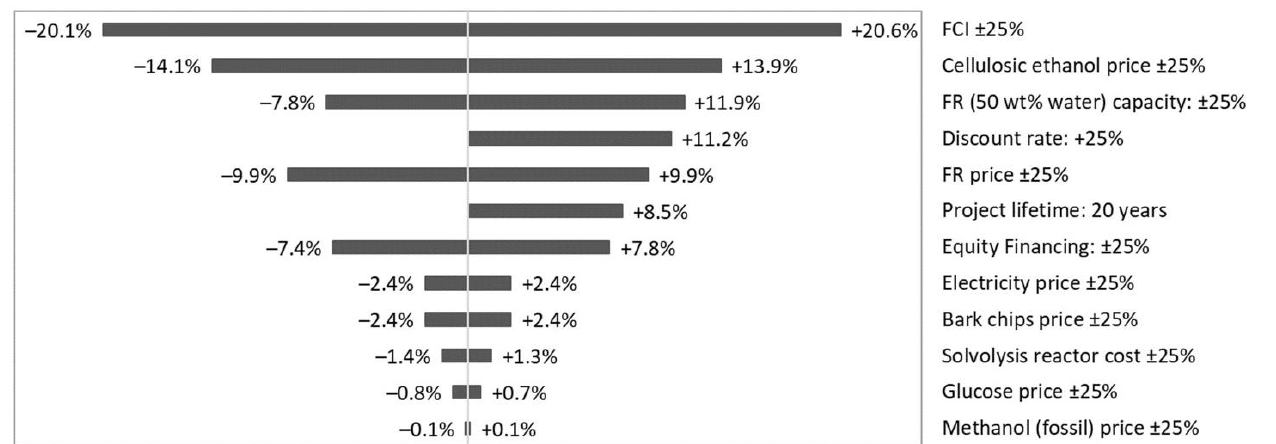
Figure 10. Impact of biorefinery capacity, financing conditions and prices on the MSP of CLO.